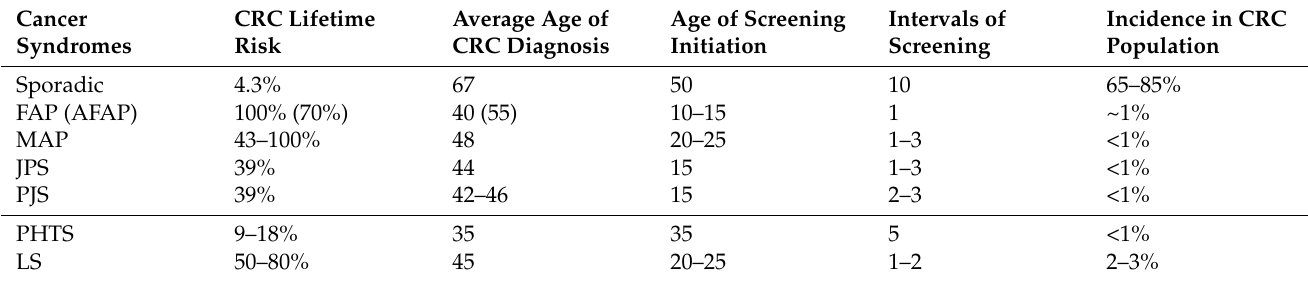
Table 1. Risk of hereditary colorectal cancer